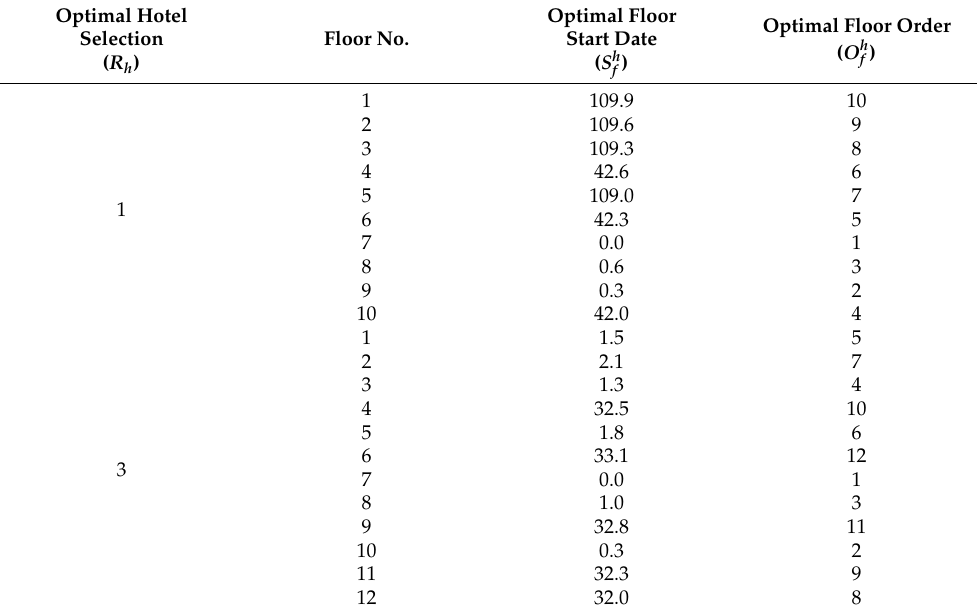
Table 8. Optimal hotel selection, floor start date, and floor renovation order.